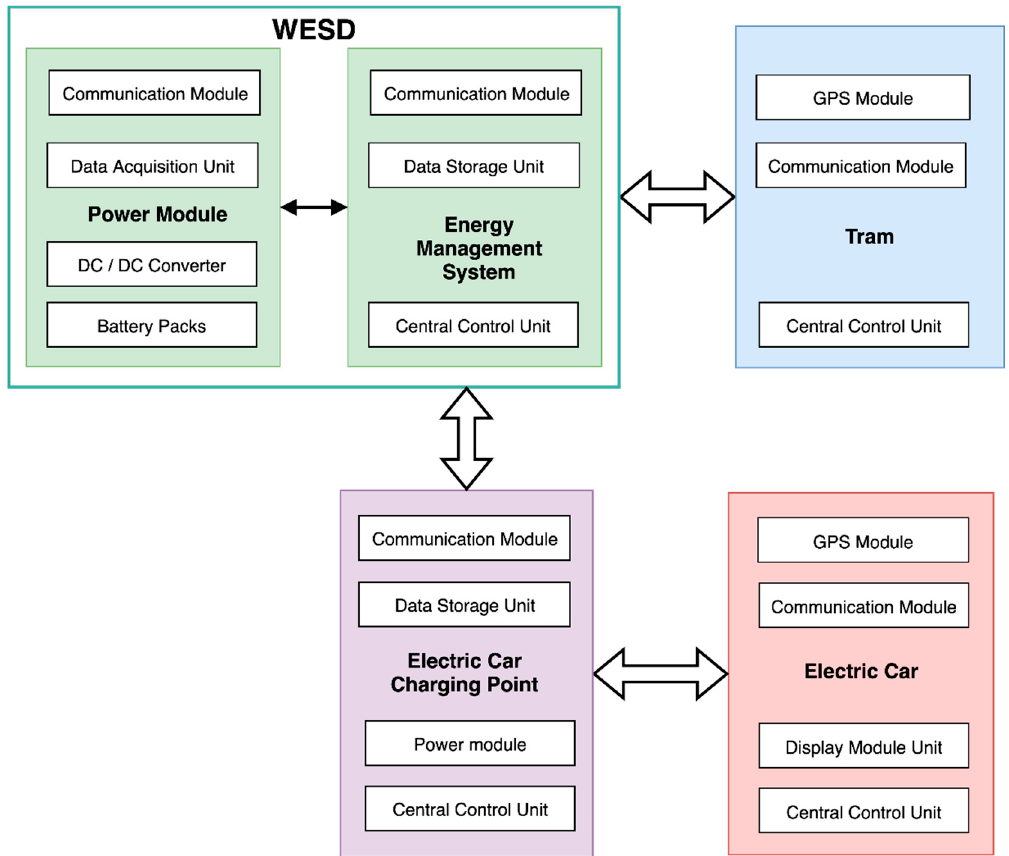
Figure 16. Control and supply system architecture for ECCP with WESD.